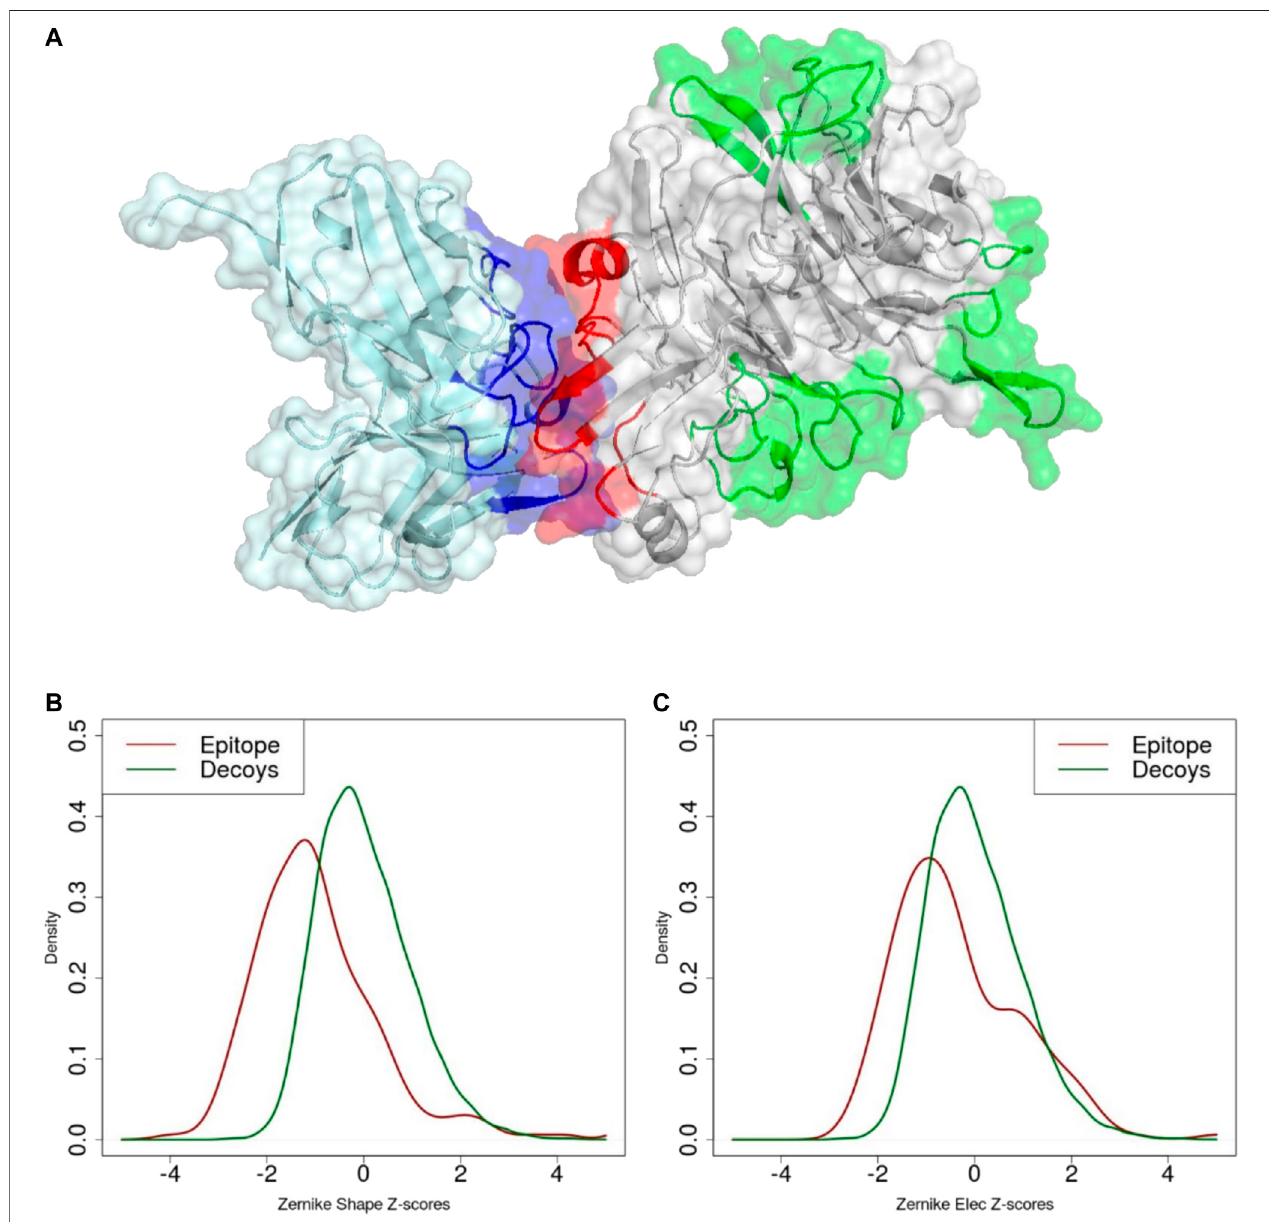
FIGURE 5 | (A) Molecular representation of experimental paratope (blue), experimental epitope (red) and decoys (green). Z-score distribution of (B) shape and (C) electrostatic surface complementarity based on the 3DZD descriptors between paratope-epitope (red) and paratope-decoy surfaces (green).